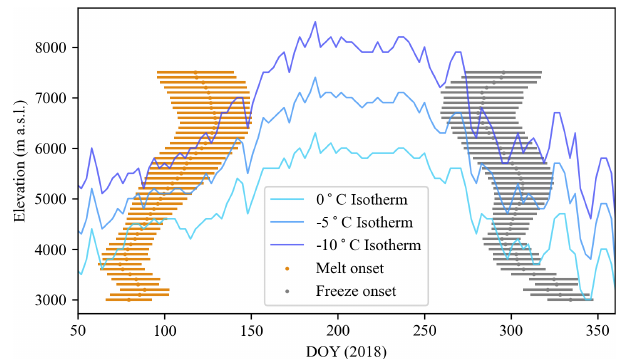
Figure 10. Sentinel-1 SAR-retrieved melt onset (orange) and freeze onset (gray), with spatial variability at ± 1 standard deviation, across the central Himalaya region. The elevations of the 0, − 5 and − 10 ◦ C isotherms from 2018 are overlaid for comparison. Melt signals are recorded in excess of 3 months at elevations extending > 1km above the maximum elevation of the 0 ◦ C isotherm, indica- tive of a sustained presence of liquid water within the snow matrix across these high-elevation